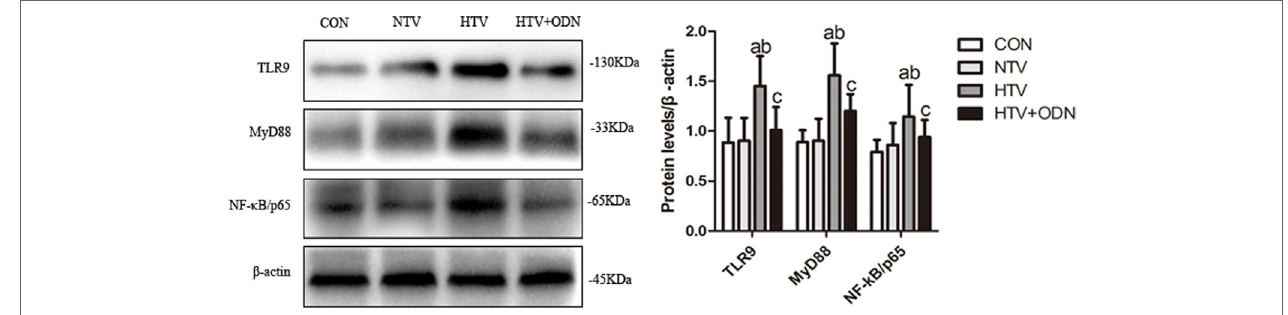
FigUre 2 | Levels of toll-like receptor (TLR) 9, myeloid differentiation factor 88 (MyD88), and nuclear factor (NF)- κ B in lung tissues from animals with spontaneous breathing (CON), mechanical ventilation at normal tidal volume (NTV), high tidal volume (HTV), and ODN2088 pretreatment upon HTV stimulation (HTV +